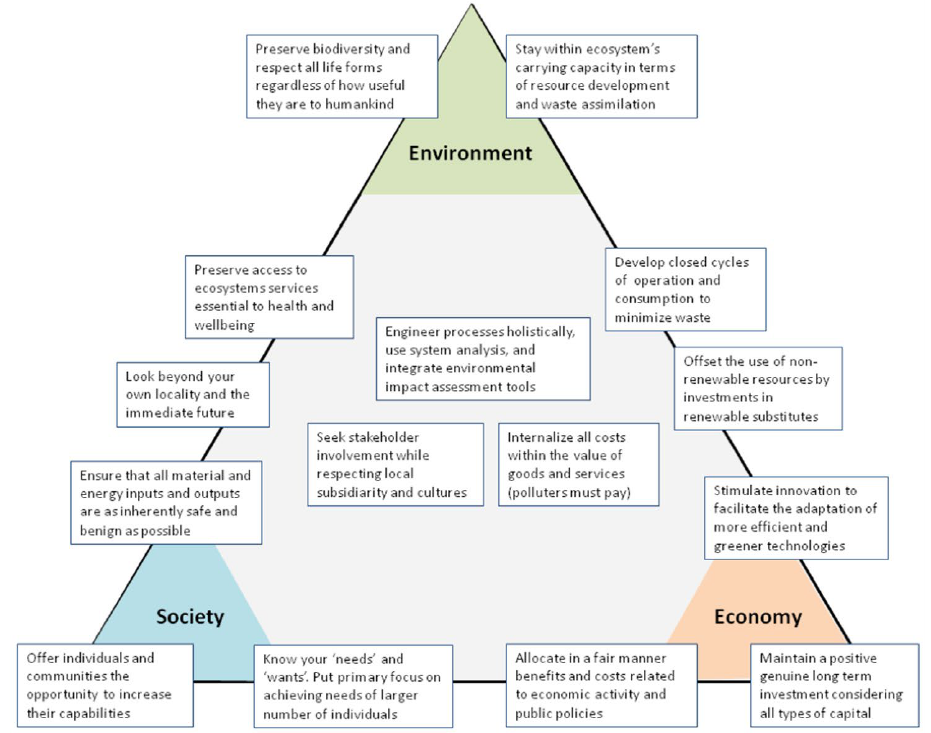
Figure 3. Classification of sustainable engineering principles versus environmental, social, and economic criteria.